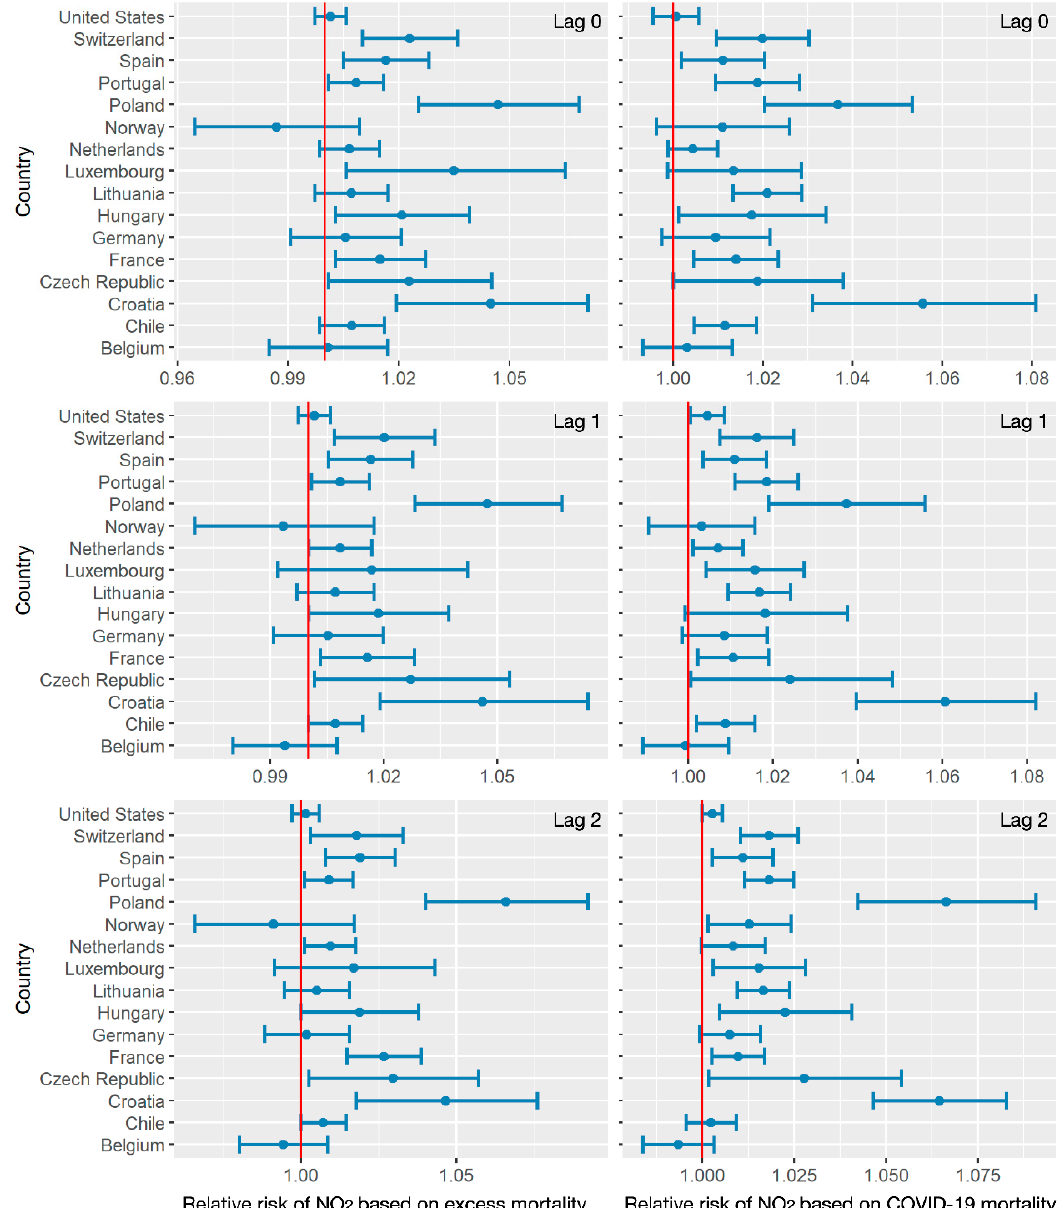
Figure 5. The relative risks of NO 2 related to excess mortality and COVID-19 mortality, with lag effects of 0,1, and 2